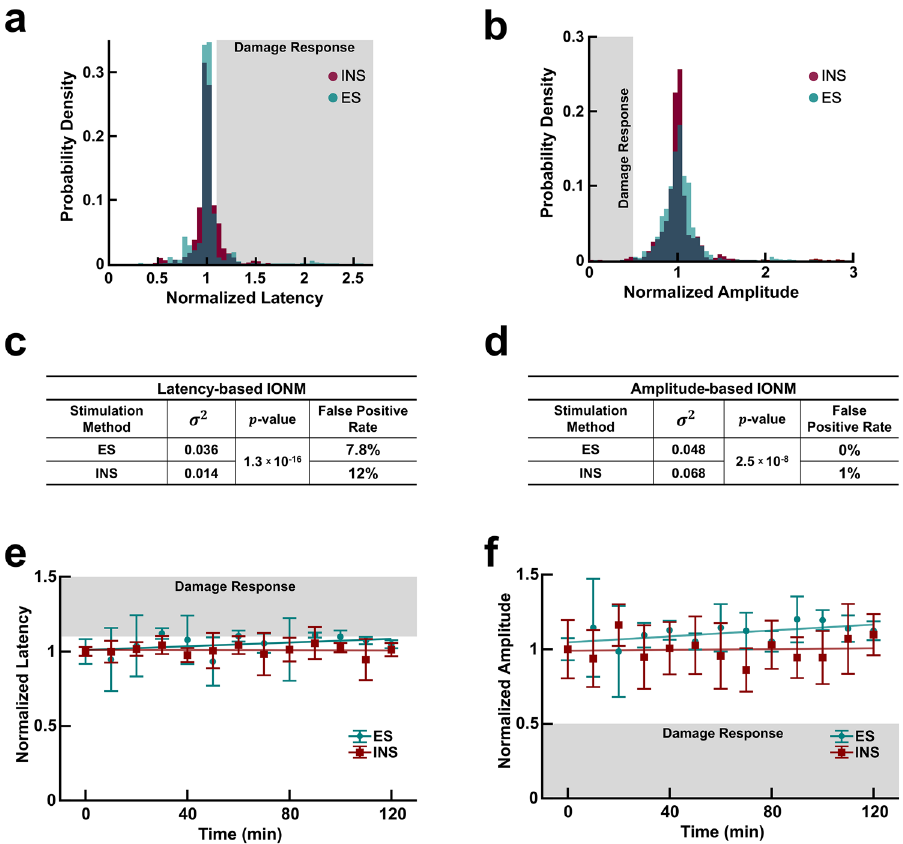
Figure 4. Electrical stimulation and infrared neural stimulation produce consistent latencies and amplitudes in undamaged nerves over extended periods of time. ( a) Probability density function of normalized latencies produced in undamaged nerves resulting from ES (teal) and INS (red). Grayed region represents latency responses that exceed the damage threshold (10% increase in latency). ( b ) Probability density function of normalized amplitudes evoked in undamaged nerves resulting from ES and INS. Grayed region represents amplitude values that fall below the damage threshold (50% decrease in amplitude). ( c ) Statistical analysis of latency variance and false positive rate ( d ) Statistical analysis of amplitude variance and false positive rate. ( e ) Time course of normalized latency values over two hours produced by ES and INS. All values normalized to the mean at t = 0 min . Linear fitting performed on all data for ES ( R course of normalized amplitude values over two hours produced by ES and INS. All values normalized to the mean at t = 0 min . Linear fitting performed on all data for ES ( R for all distribution graphs [ a – d ; 15 rats total]; n = 3 nerves and rats for time course plots ( e – f